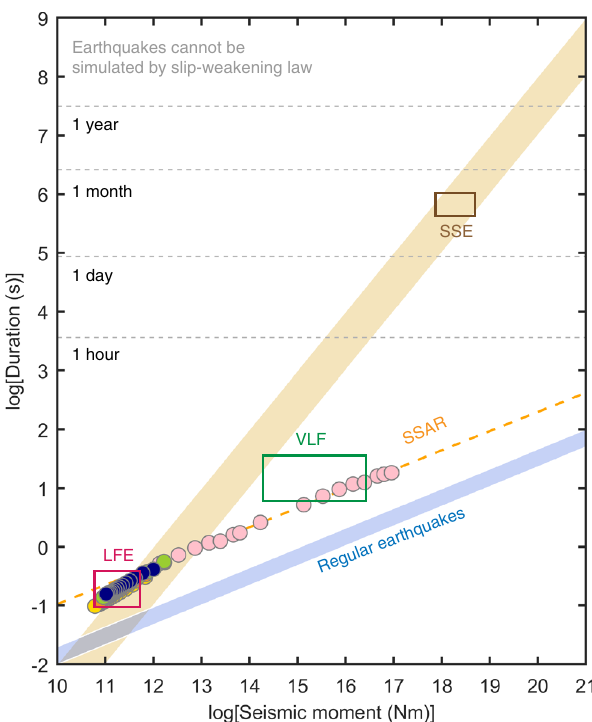
Fig. 4 Moment-duration scaling relationship of SSARs. The yellow strip denotes the linear scaling of slow earthquakes reported by Ide et al. 2007 24 . The blue strip denotes the cubic scaling of regular earthquakes. The pink dots denote the SSARs with rupture patch diameters ranging from 200 m to 9 km. The blue, green, orange, and yellow dots show the scaling of SSARs we used before to simulate the LFEs. The blue, green, orange, and yellow dots denote simulated earthquakes with rupture diameter 300 m, 260 m, 220m, and 180 m, respectively. The orange dashed line shows the fi tting result of SSARs. The red rectangle is the area of magnitude and duration consistent with LFEs. The green rectangle is the area of magnitude and duration consistent with VLFs, and the brown rectangle is the area of magnitude and duration consistent with